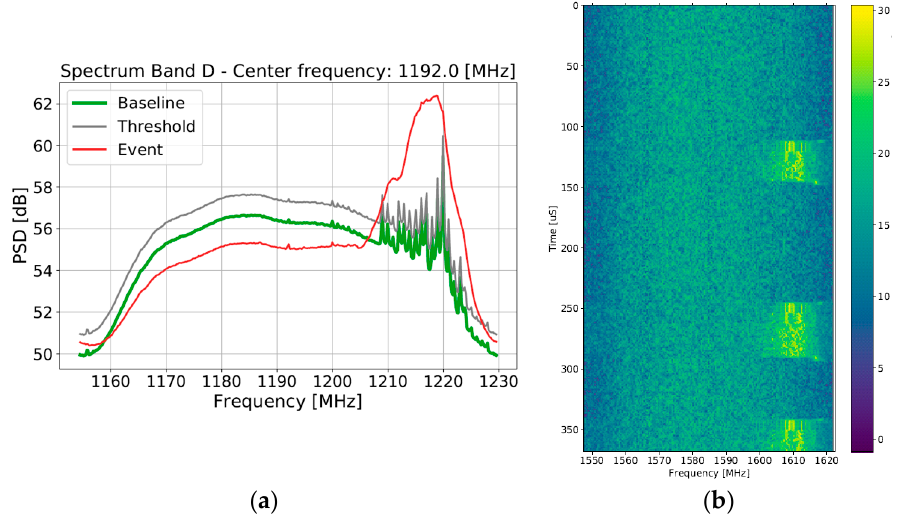
Figure 10. Examples of ( a , b ) a malfunctioning Wi-Fi router radiating at half of the nominal frequency of operation.